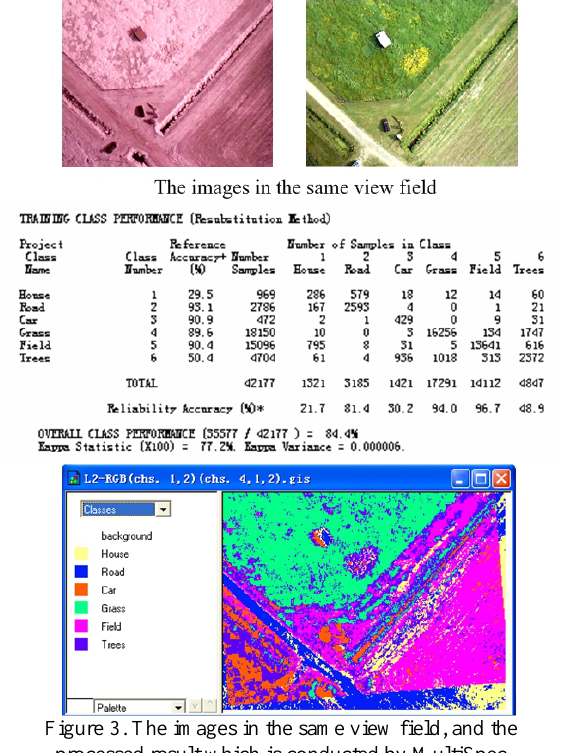
Figure 3. The images in the same view field, and the processed result which is conducted by MultiSpec By coupling digital aerial and ground photos, A-GPS, field data collected with the mobile devices and web